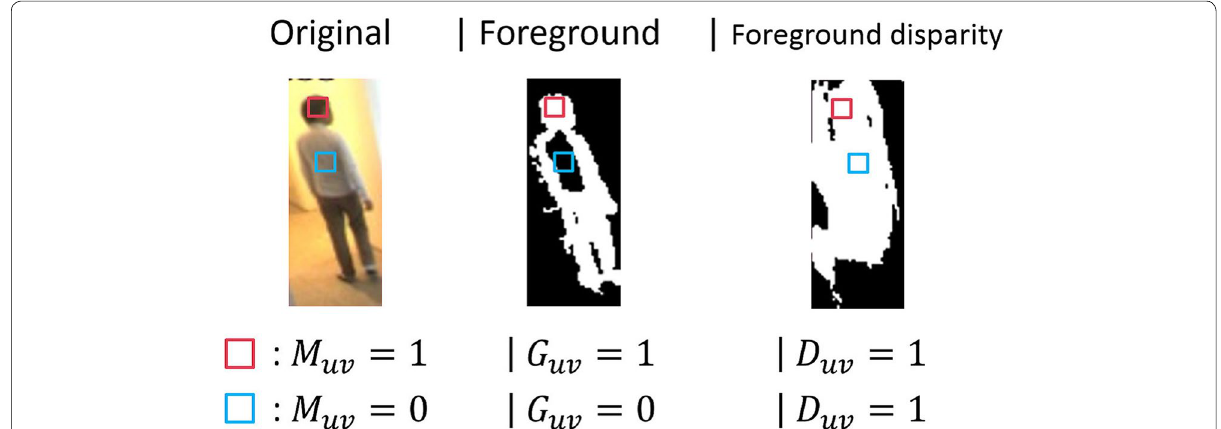
Fig. 5 Scoring based on foreground and foreground disparity images. M uv represents logical product of G uv and D uv